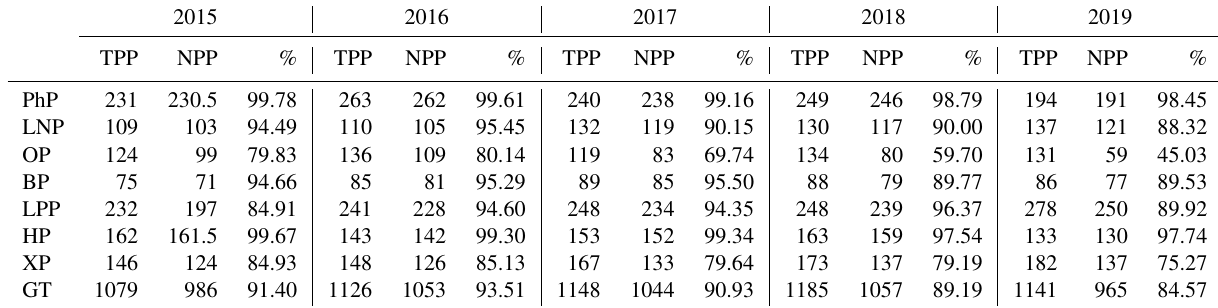
Table 1. The trend of indigenous pig population in northern Laos from 2015–2019 (thousand heads).